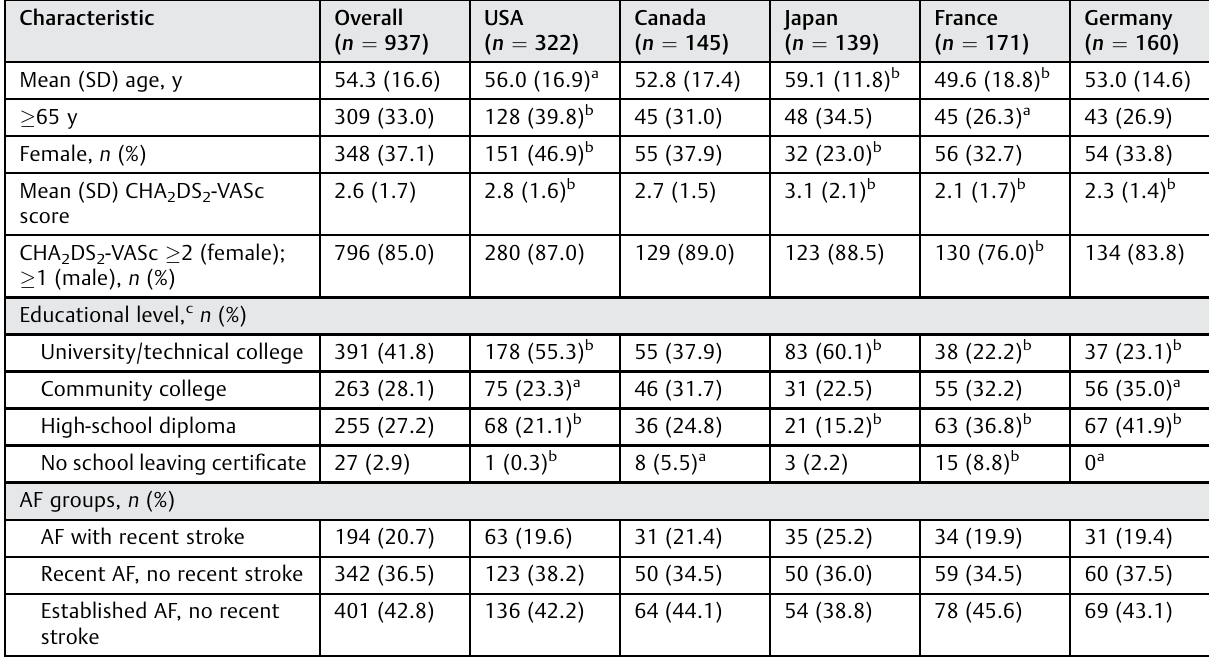
Table 1 Patient baseline demographic and clinical characteristics overall and by country